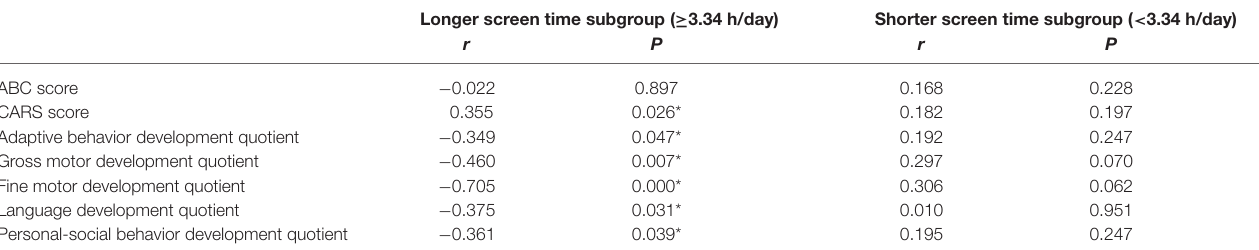
TABLE 3 | Correlations between screen time and ASD-related scale scores and development quotients in the longer and shorter screen time subgroups. Longer screen time subgroup ( ≥ 3.34